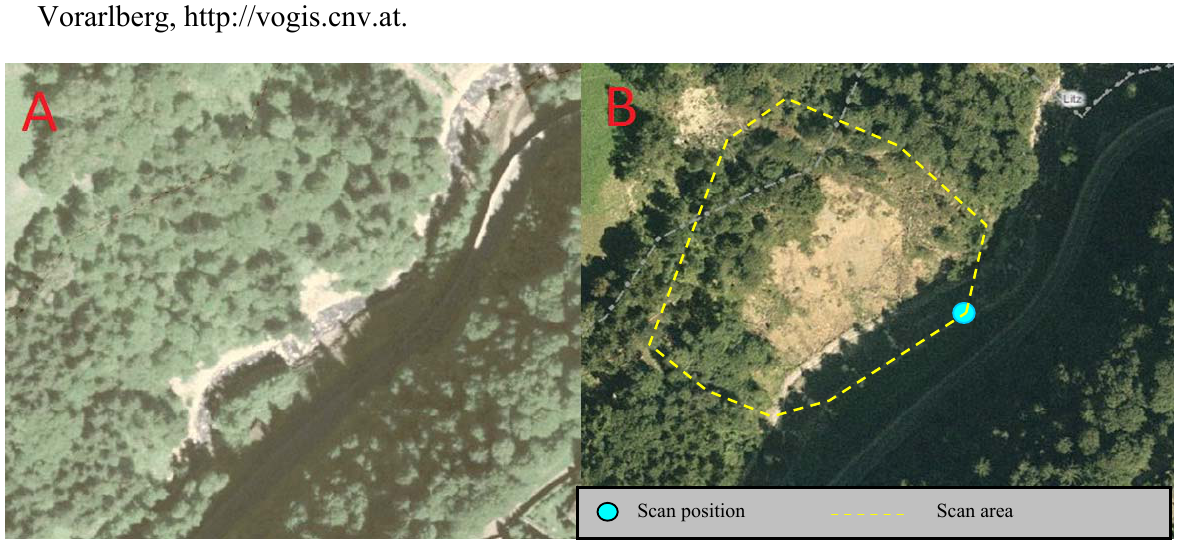
Figure 8. Location of the two test areas; image source: © Geoland,